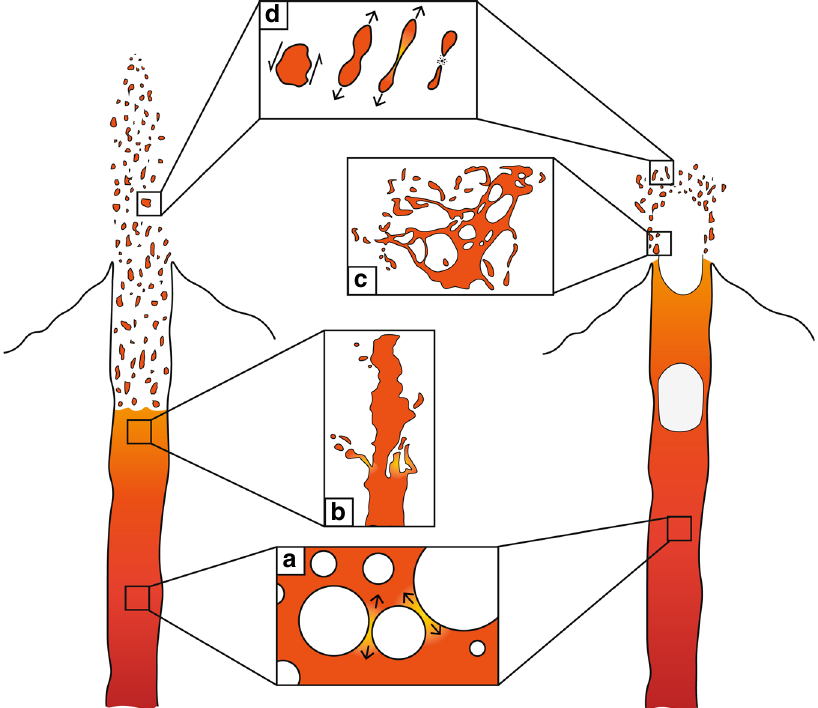
Fig. 1 A schematic showing the potential locations where the fl uid dynamic break-up of a low-viscosity melt is important. These illustrations are not exhaustive but include a fi lament formation and extension by bubble growth and expansion, b instabilities on the edge of a jet, c the bursting of bubbles